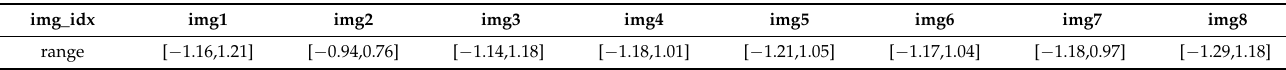
Table 3. Output range of BE-AUTO-base on 8 random selected